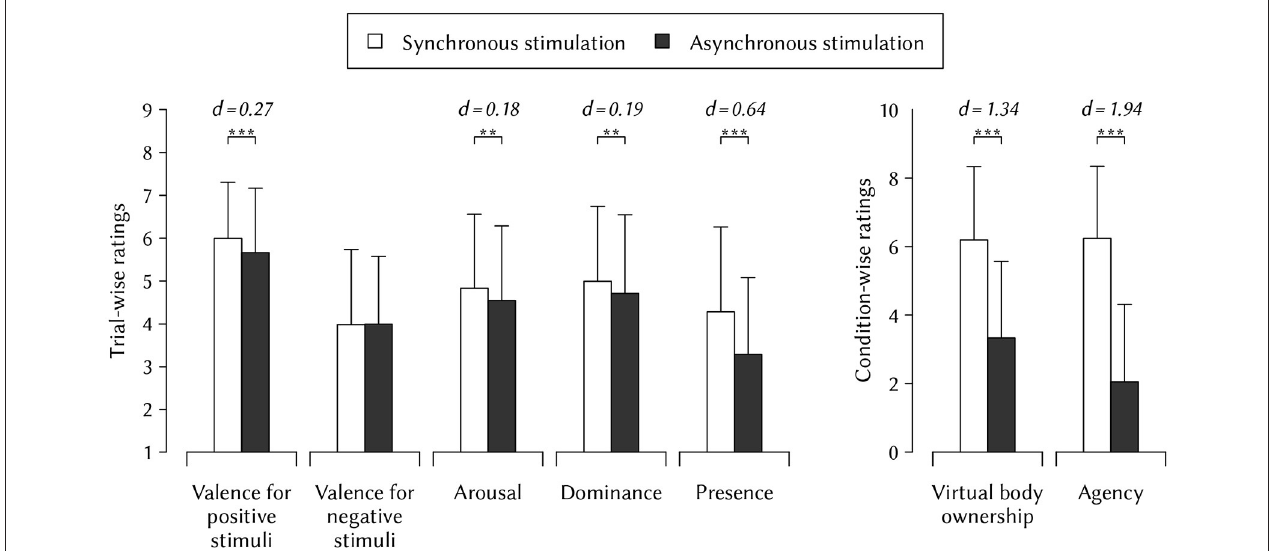
FIGURE 3 | Results. Mean (+ SD) of trial-wise self-assessment manikin and presence ratings, as well as condition-wise questionnaire ratings. Participants reported significantly higher valence for positive stimuli, arousal, dominance, and presence when they receive synchronous compared to asynchronous stimulation. The manipulation check revealed significantly higher virtual embodiment and agency after synchronous compared to asynchronous stimulation. The p -values indicate significant results of Bonferroni-Holm adjusted mean comparisons. Cohen’s d values indicate effect sizes. Self-assessment manikin ratings range from 1 ( low / negative ) to 9 ( high / positive ). Questionnaire ratings range from 0 ( not at all ) to 10 ( totally ). Abbreviations: ** p < 0.01, *** p <